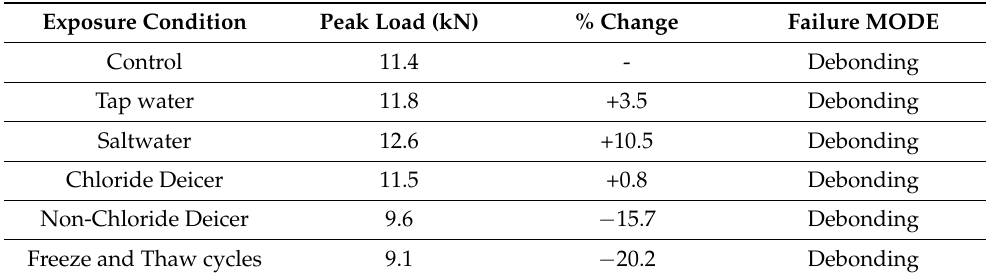
Table 6. Peak loads from the three-point bending tests after 30 cycles of